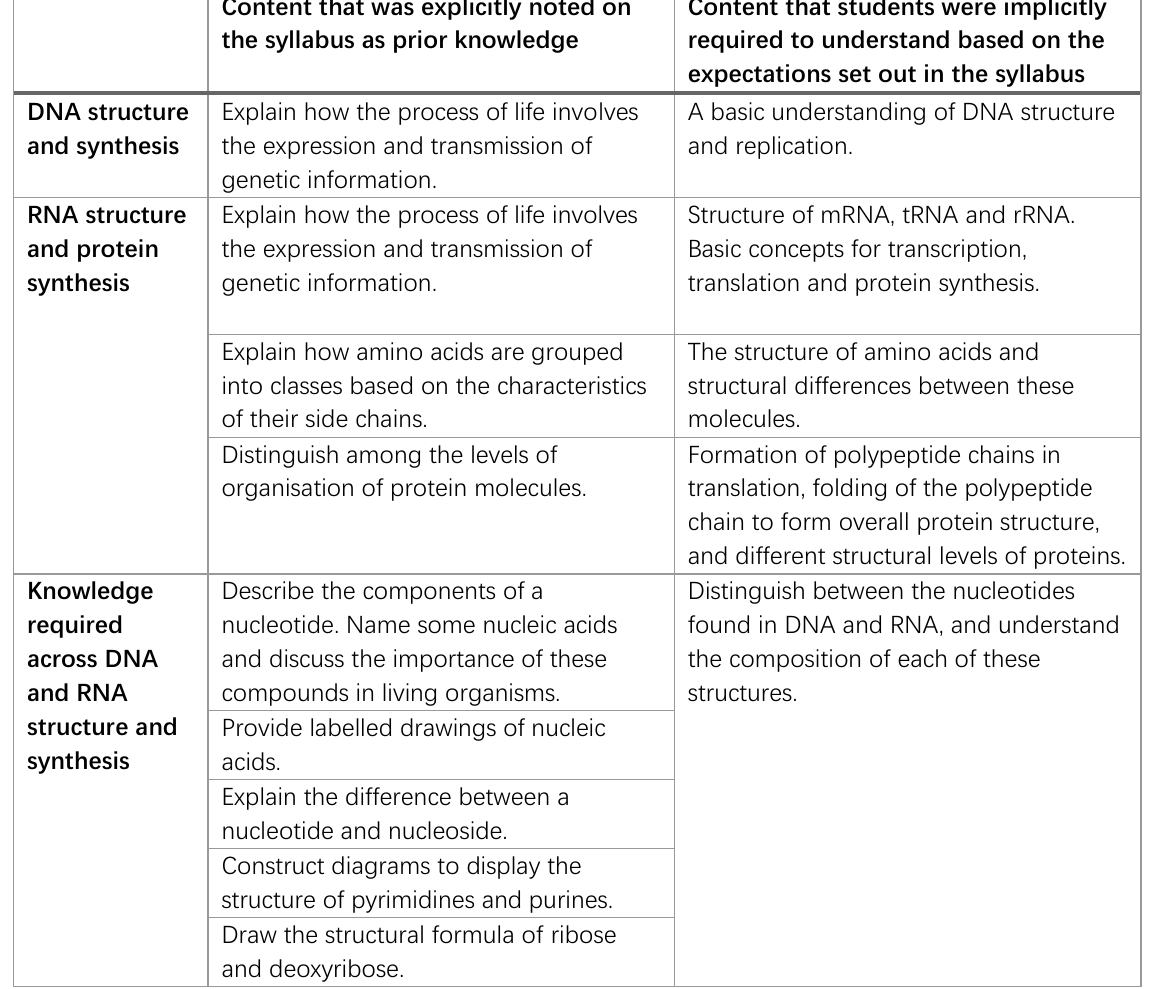
Table 2 : Explicitly and implicitly required prior knowledge on DNA and RNA synthesis according to the prescribed